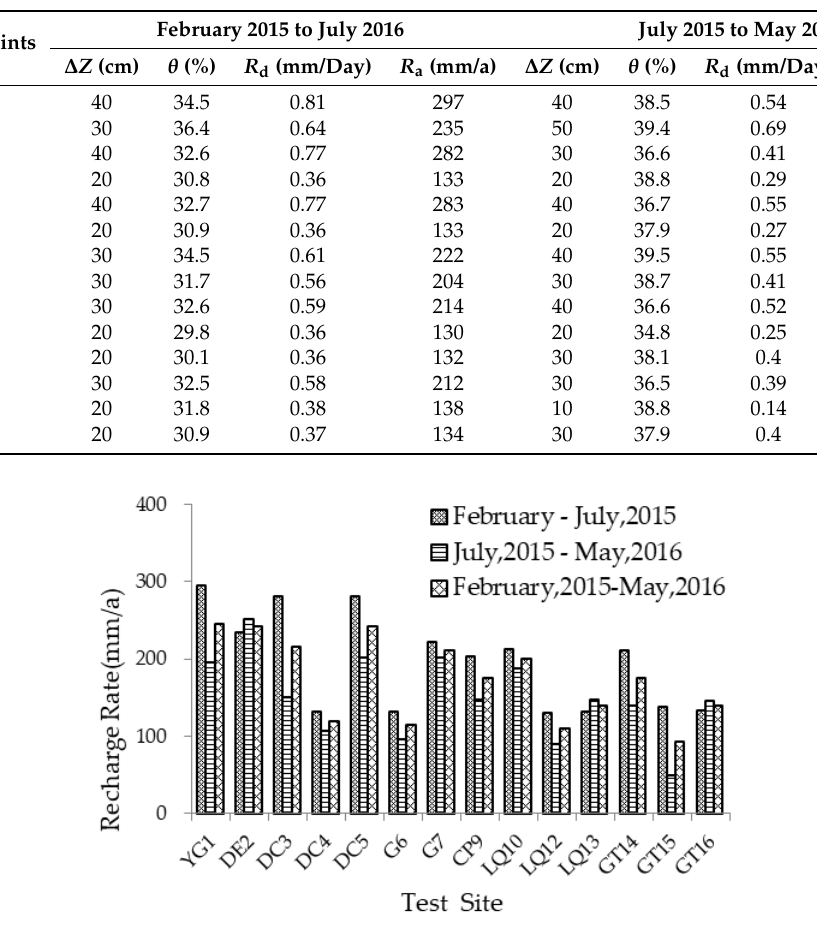
Table 3. The recharge rate of groundwater.